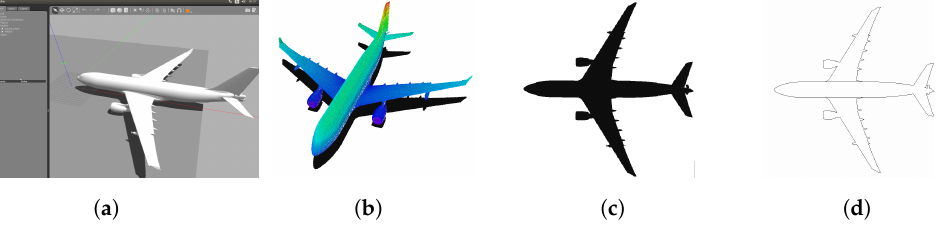
Figure 7. 2D occupancy grip map creation process. ( a ) Airbus A330 Gazebo Model. ( b ) Octomap generated with 0.1 cm voxel resolution. ( c ) Octomap horizontal projection. ( d ) Modified 2D occupancy grip